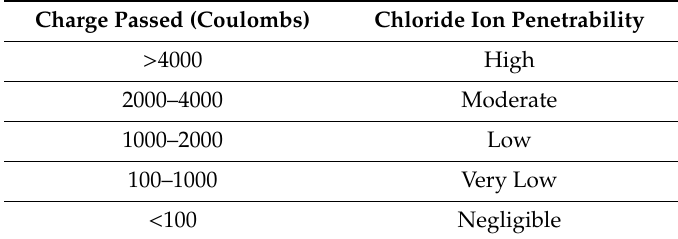
Table 2. RCPT ratings (as per ASTM C1202).